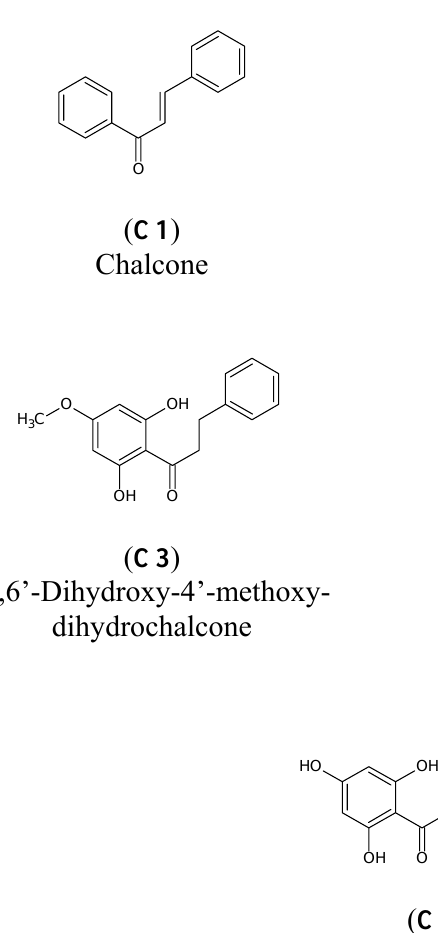
Figure 1. Chemical structures of the studied chalcones and